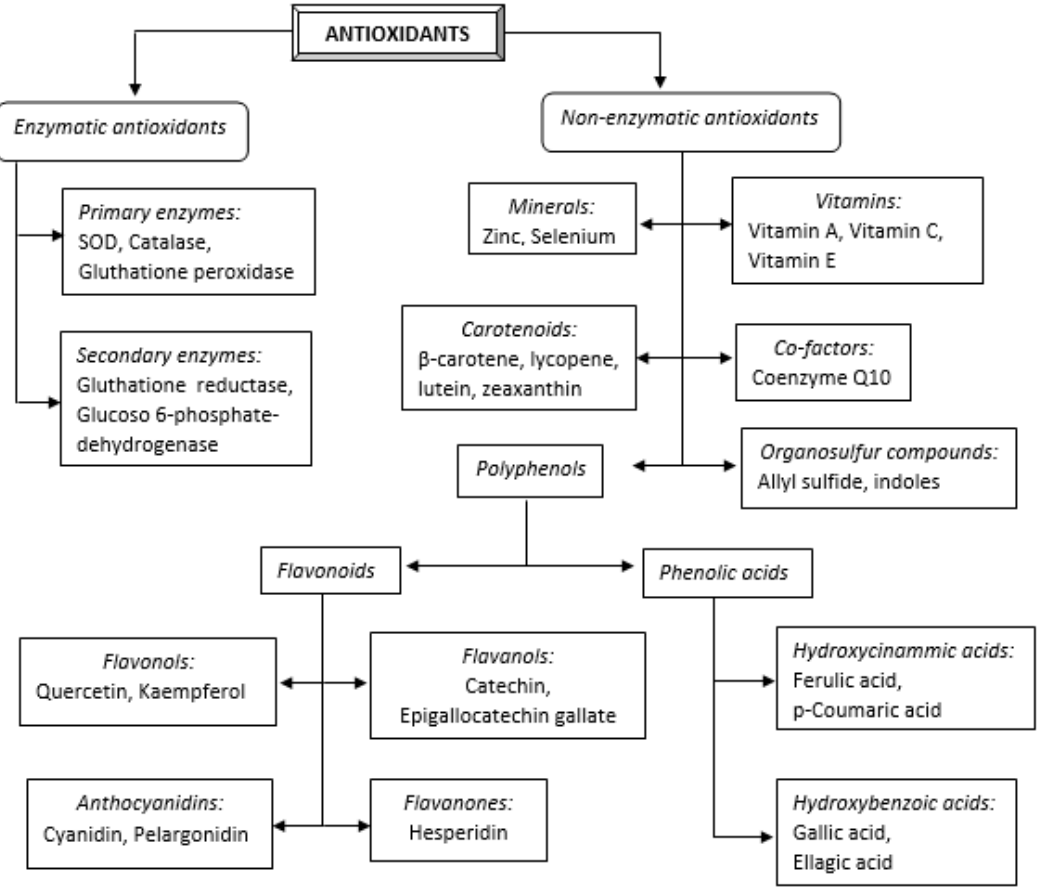
Figure 1. Classification of antioxidants.